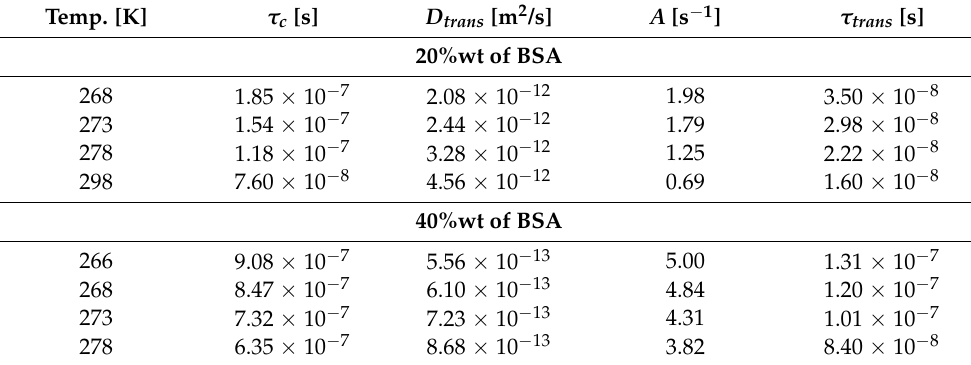
Table 2. Parameters obtained from the analysis of 1 H spin-lattice relaxation data for BSA–water mixtures in terms of Equation (5). The dipolar relaxation constant, C DD , for 20%wt concentration of BSA yields: C DD = 7.29 × 10 6 Hz 2 , N H = 1.52 × 10 27 /m 3 ; the corresponding values for 40%wt